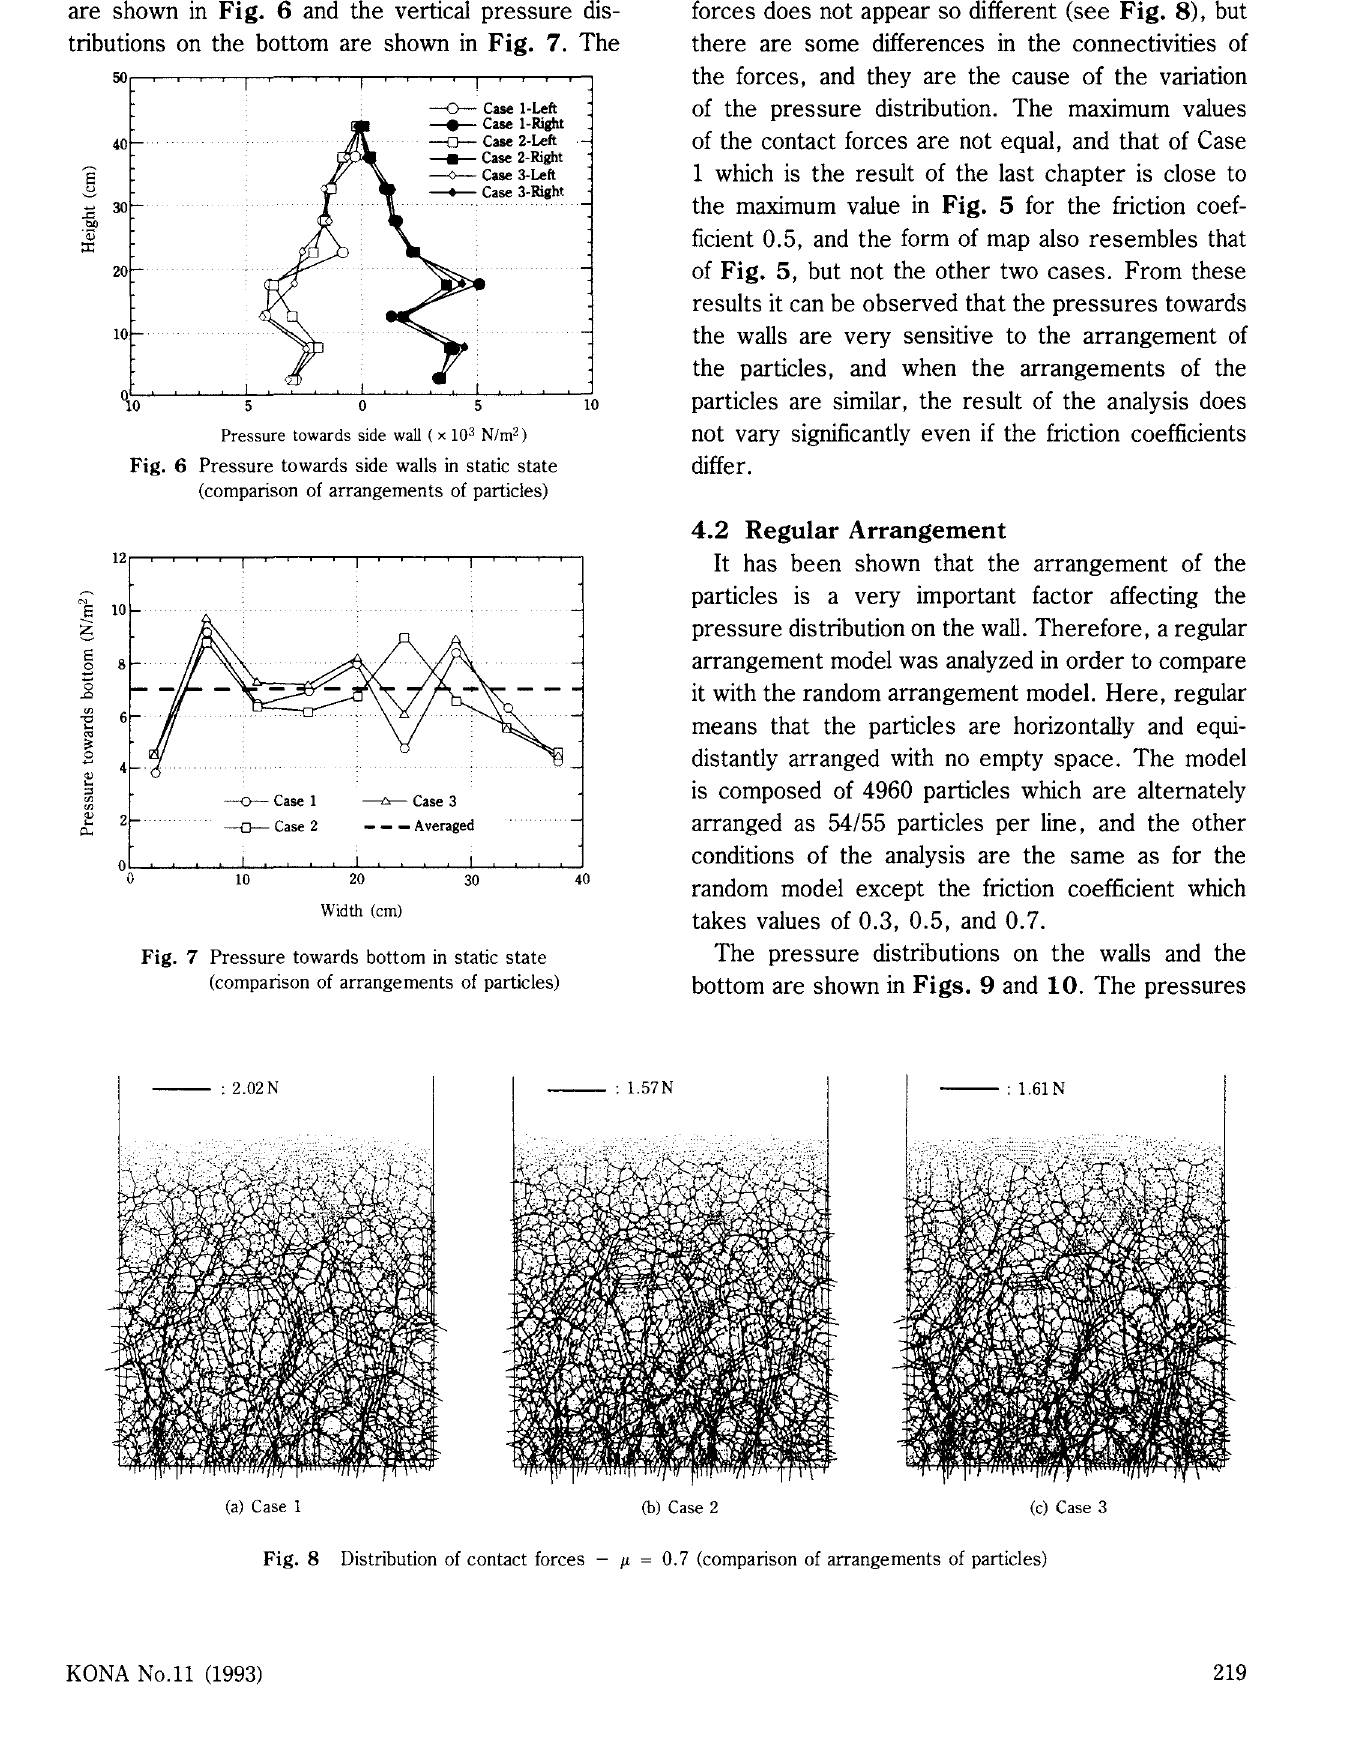
Fig. 8 Distribution of contact forces - p. = 0. 7 (comparison of arrangements of